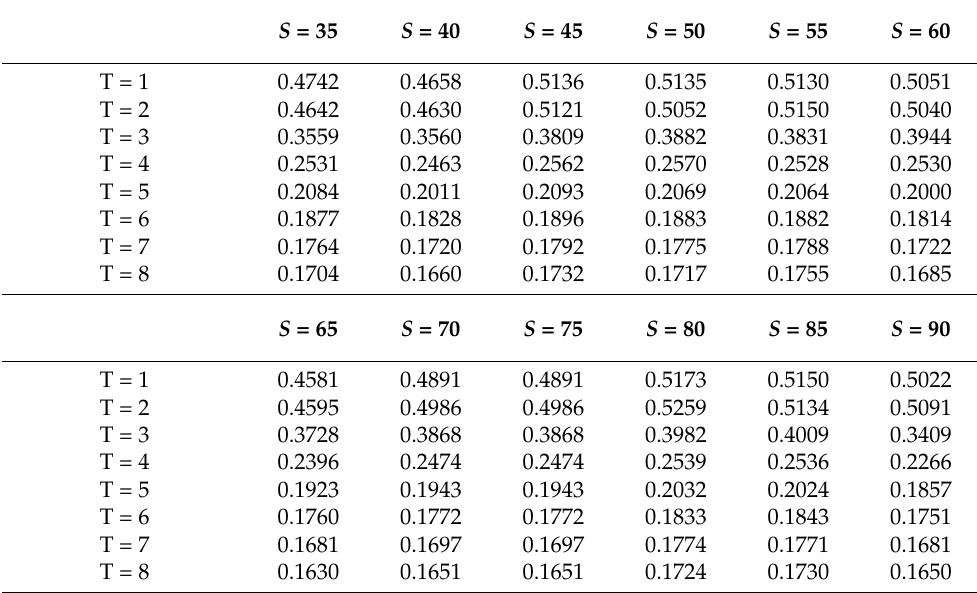
Table A14. The IoU of RF varies with sampling size S and threshold level T.